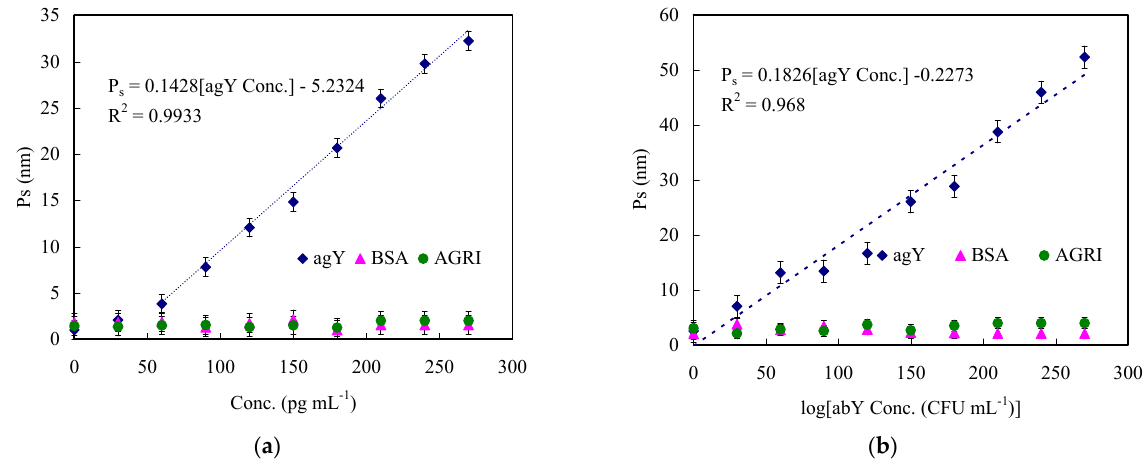
Figure 6. P s of peaks ( a ) IV and ( b ) V as a function of agY concentration (0–270 pg mL − 1 ). Figures 7a and 7b display the P s values of peaks IV and V, respectively, for different agY concentrations and BSA/AGRI concentrations various times that of agY. At concentrations 10, 100, and 1000 times that of agY ([agY] = 90, 150, and 210 pg mL − 1 ), BSA and AGRI had a negligible effect on the P s of peaks IV and V, indicating high selectivity attributable to proG modification. The adsorption sites were occupied mostly by proG, which resulted in anti ‐ biofouling properties and high selectivity.